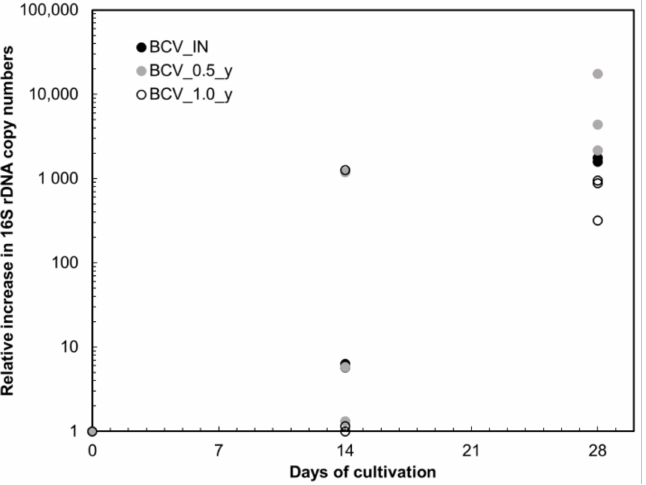
Figure 6. qPCR analysis of the 16S rDNA gene in anaerobically cultivated bentonite